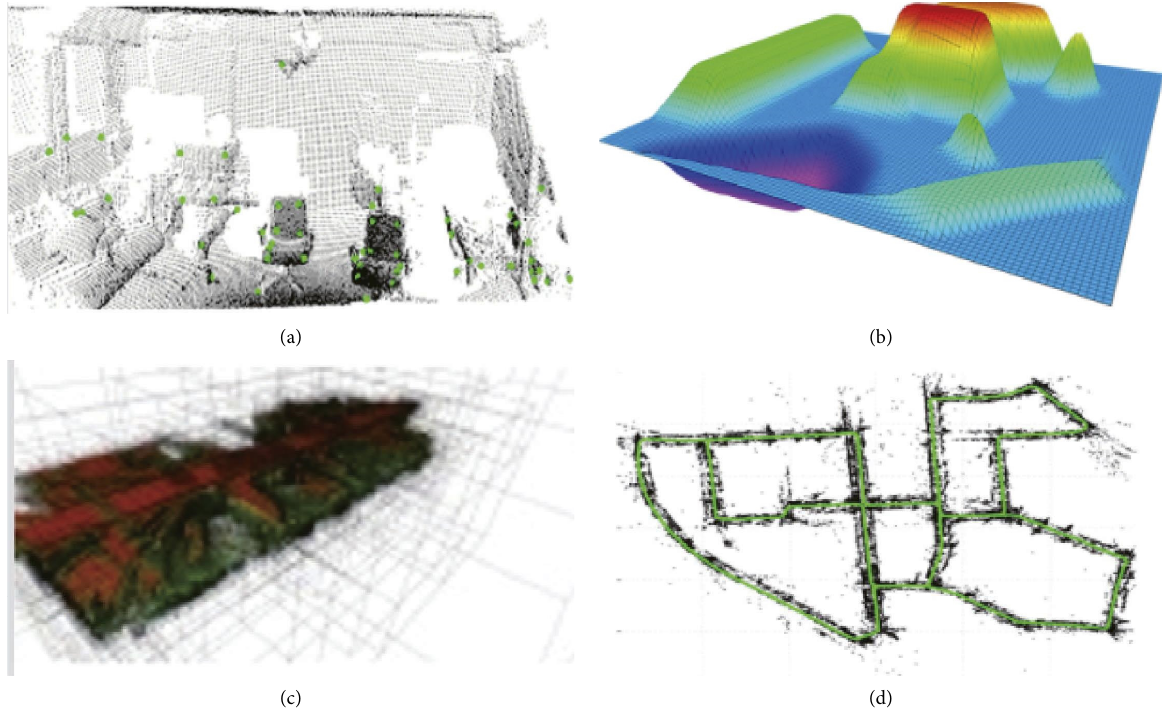
Figure 8: (a) Te point cloud map. (b) Te occupancy grid map. (c) Te grid map. (d) Te octree map.